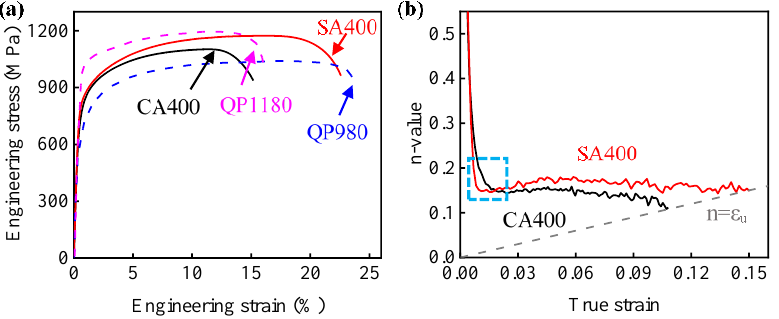
Figure 6. ( a ) Engineering strain-stress curves; ( b ) instantaneous work-hardening ( n -value) versus true strain. Table 1. Tensile properties of the studied samples.